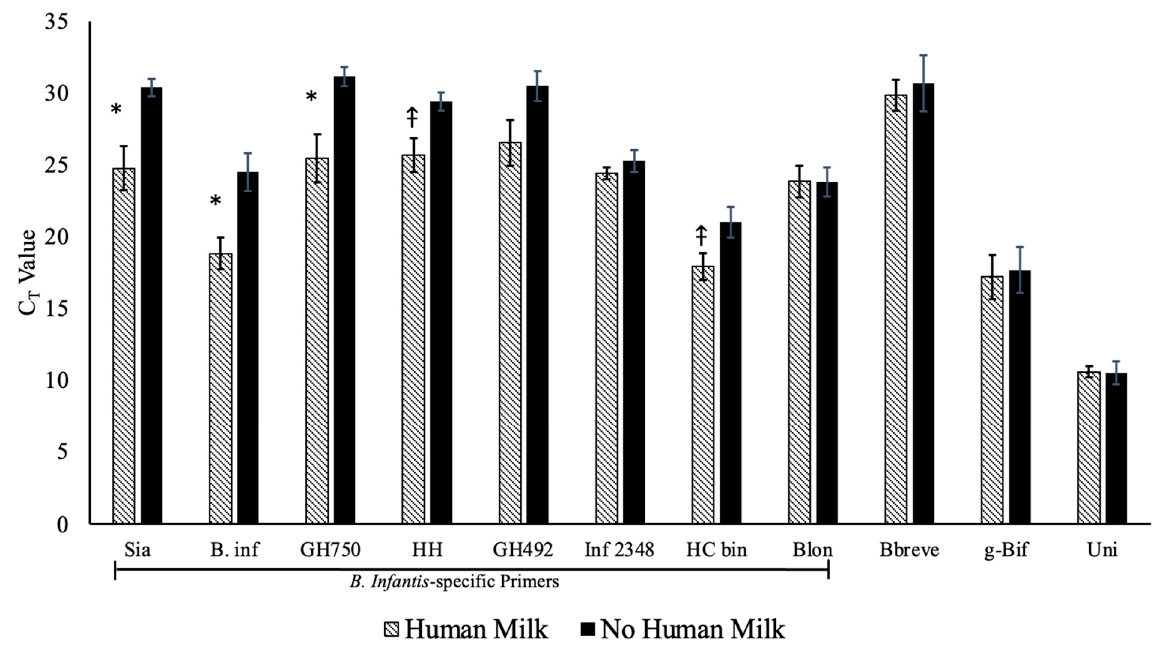
Figure 2. The abundance of each gene (displayed as the Ct value) for the infants who consumed any amount of human milk versus those who consumed no human milk. The data are means ± SD; * p < 0.05; ⤉ p < 0.10. Note that the higher the C T value, the lower the gene abundance.